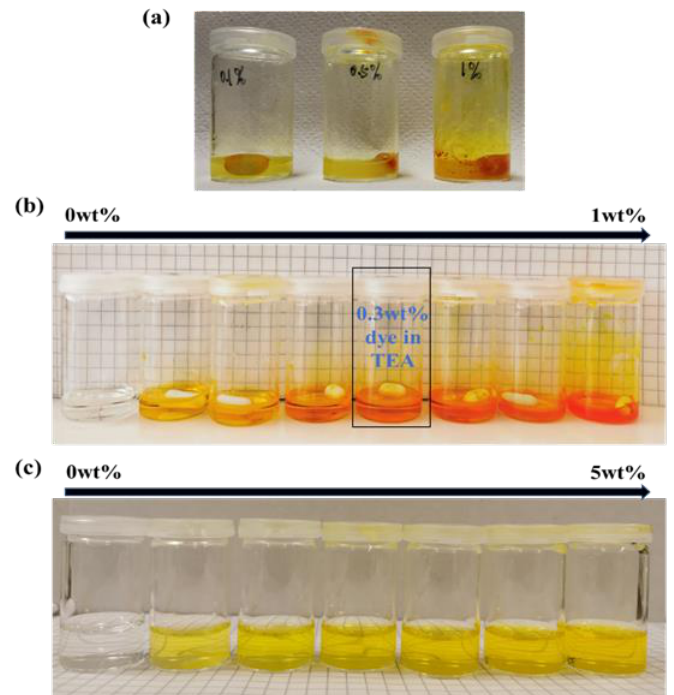
Figure 1. Pictures of ( a ) dye in water with different concentrations from 0.1 wt% to 1 wt%; ( b ) dye in TEA with different concentrations of 0 wt%, 0.05 wt%, 0.1 wt%, 0.2 wt%, 0.3 wt%, 0.4 wt%, 0.5 wt%, 1 wt%; ( c ) [dye-TEA] (0.3 wt% of dye in TEA) in water for different contents: 0 wt%, 0.5 wt%, 1 wt%, 2 wt%, 3 wt%, 4 wt%, 5 wt%.